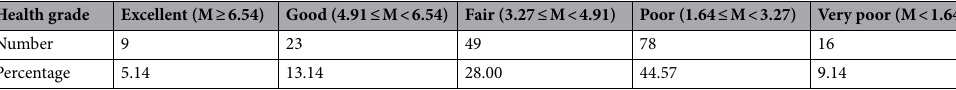
Table 5. B-IBI health assessment grade of the sampling sites.